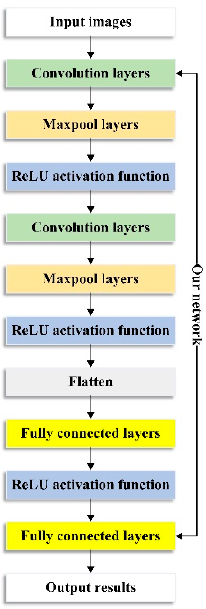
Figure 3. The architecture of our network.